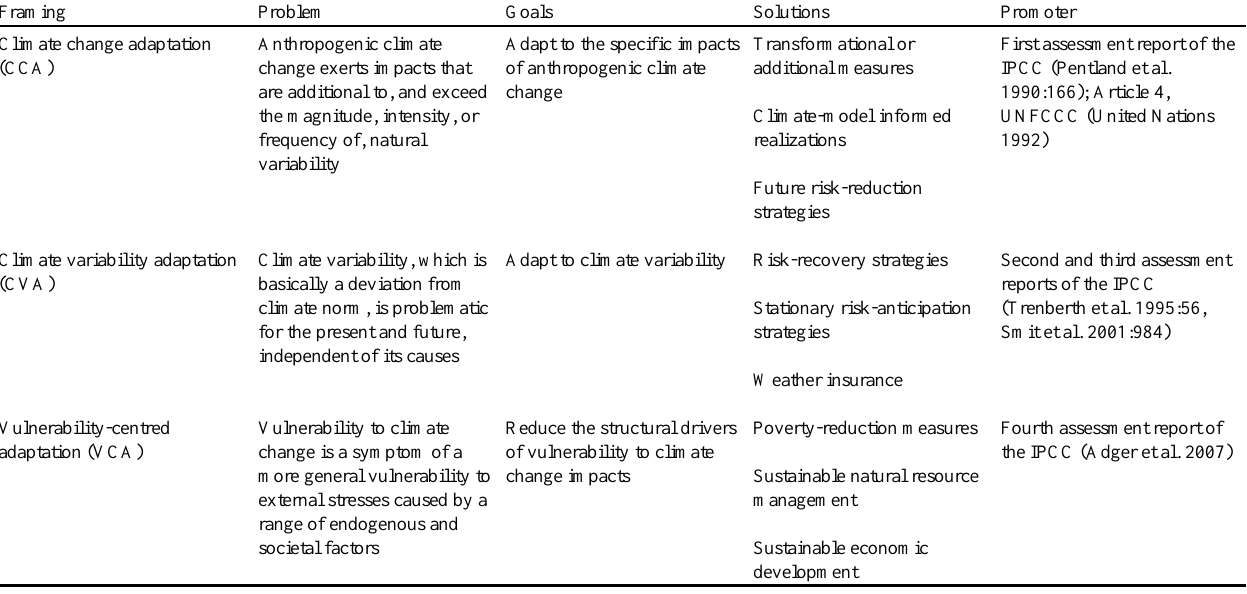
Table 1. Ideal types of adaptation